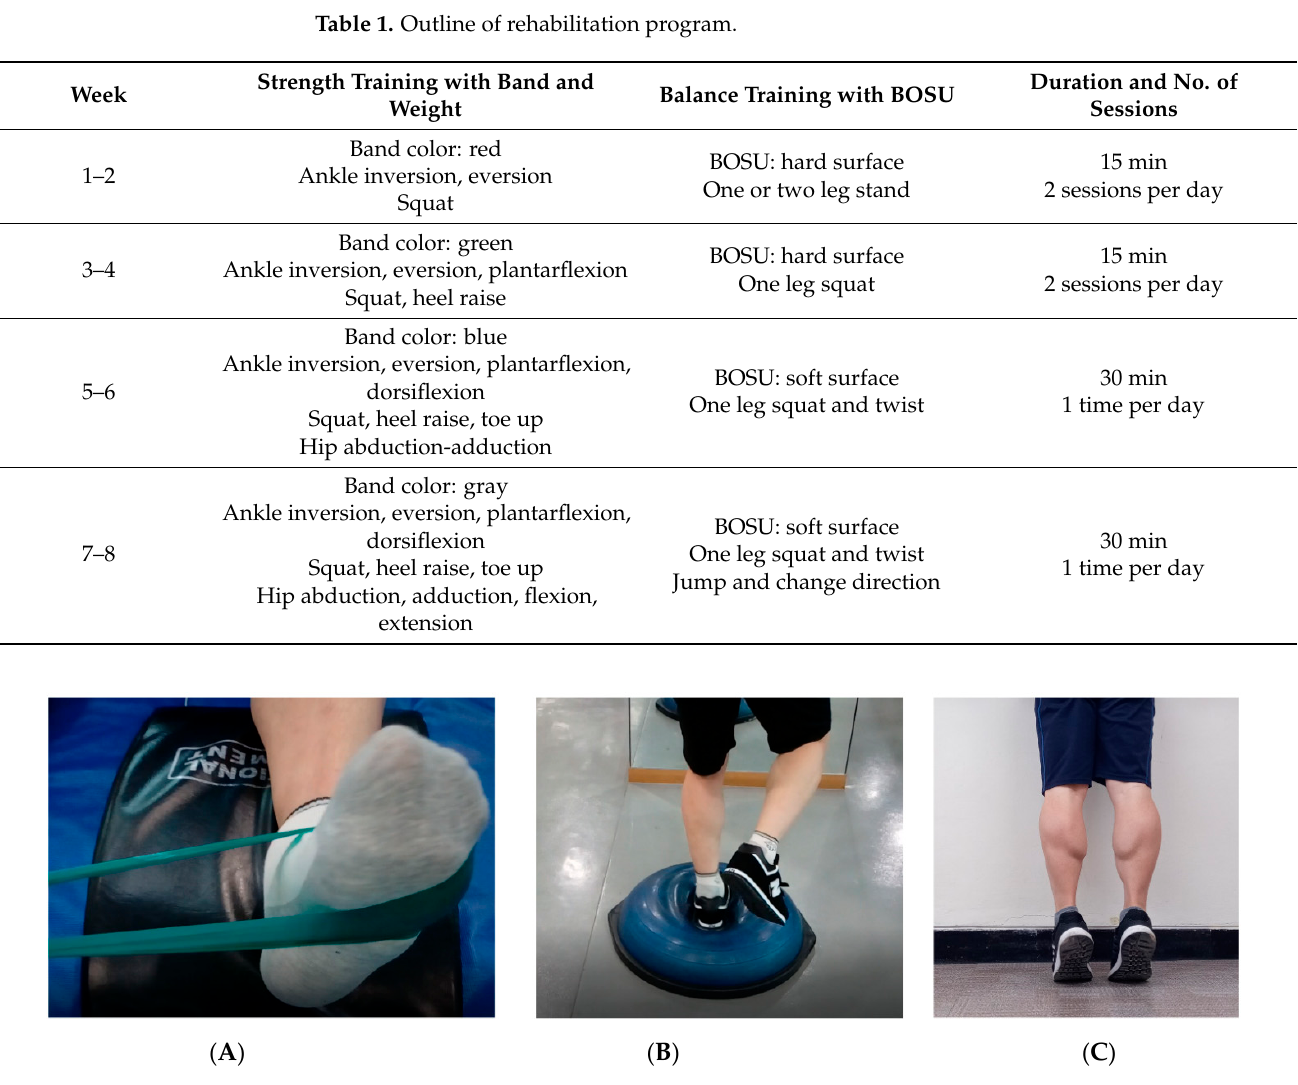
Figure 2. Photographs showing ( A ) ankle strength training with tube band; ( B ) balance training with BOSU; ( C ) heel raise strength training with body weight.